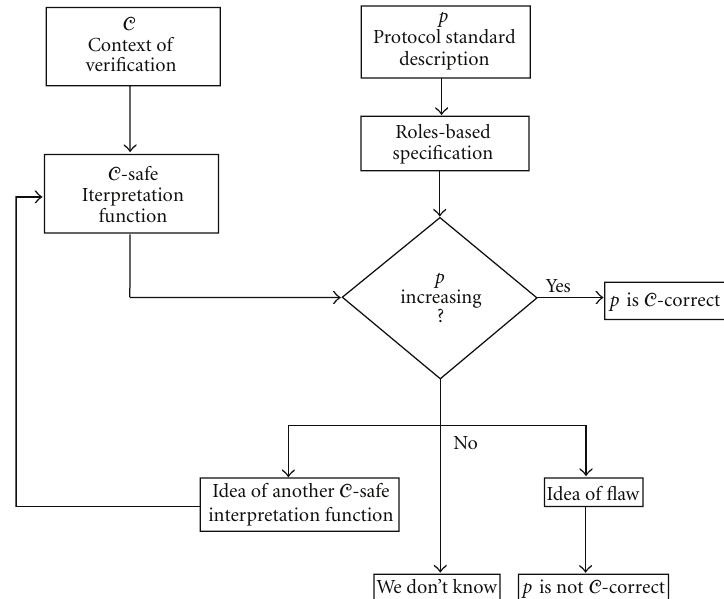
Figure 2: Protocol verification